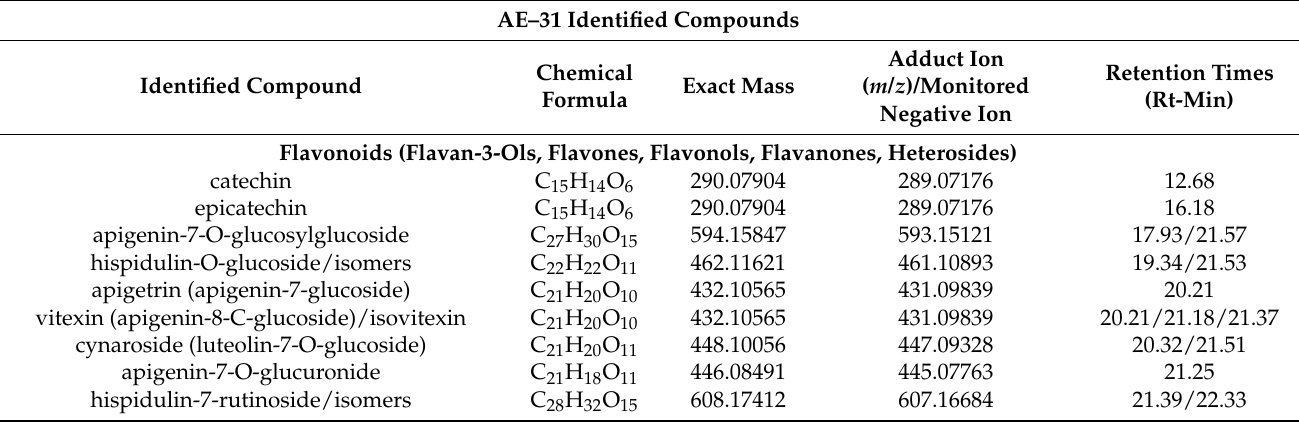
Table 6. Chemical compounds identified in AE by